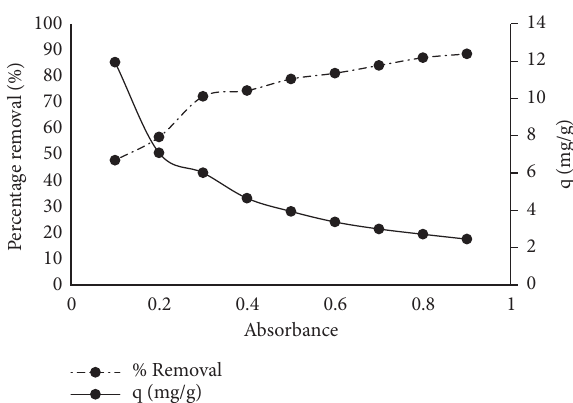
Figure 3: Influence of HAB dosage on GV removal.